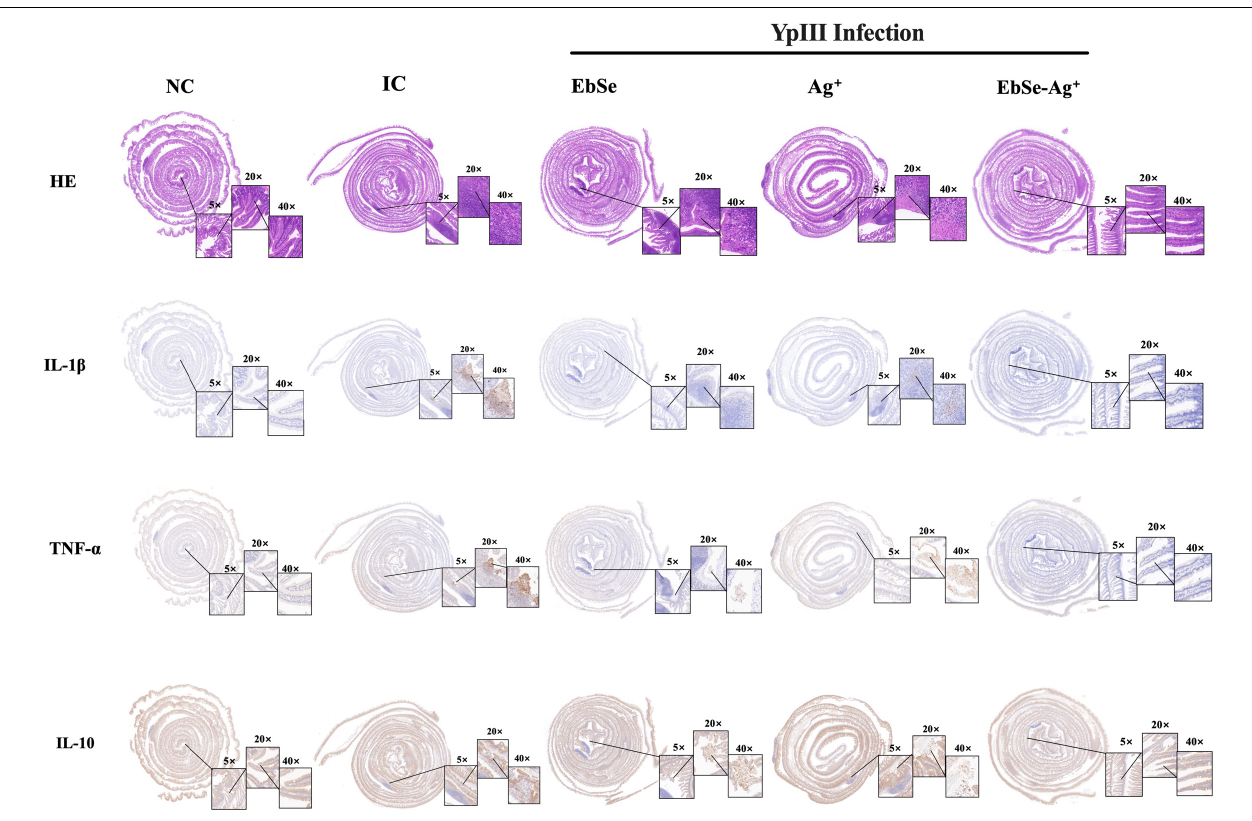
FIGURE 10 | EbSe-Ag + has immune-modulatory property. YpIII-illuminous were orally administrated into mice, and further treated with EbSe-Ag + . Mice intestinal tracts were rolled, fixed, and embedded. Paraffin sections were used to perform H&E stain and detect cytokine (IL-1 β , TNF- α and IL-10) levels by IHC analysis.